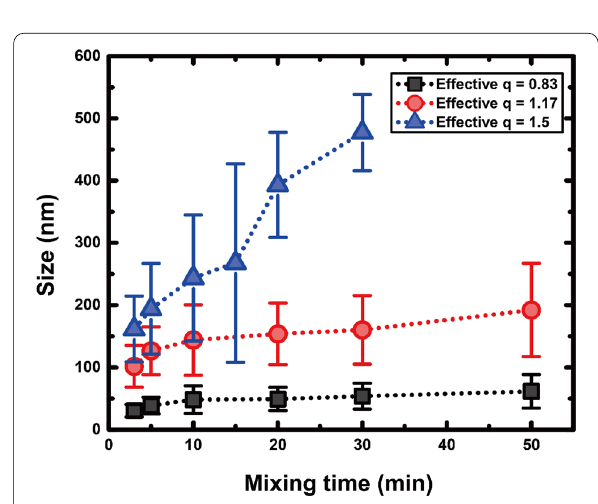
Fig. 6 The size of the vesicles transitioned from bicelles having different effective q-value depending on the stirring time. The dilution was performed by adding threefold volume of buffer to bicelle solution and temperature was consistently maintained at 20 °C for all samples during